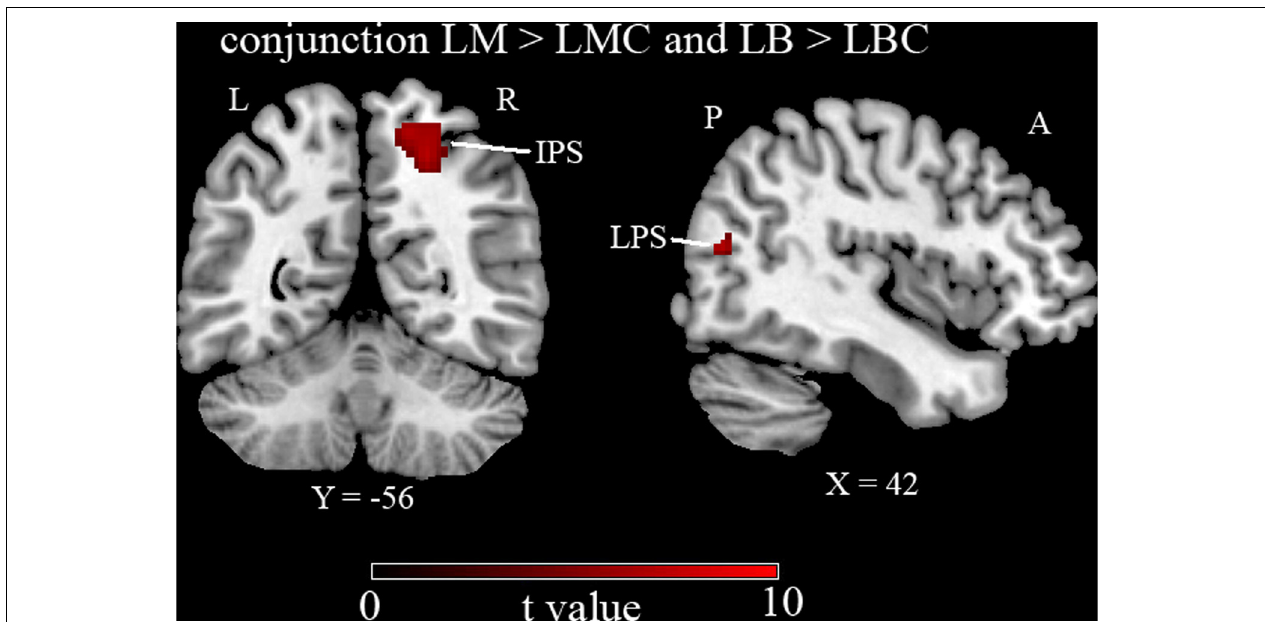
FIGURE 3 | Group results thresholded at p < 0.05 corrected for multiple comparisons. Intra-parietal sulcus (IPS) and lateral peristriate cortex (LPS) activated (please see Table 2 for coordinates) commonly for both Landmark and Line Bisection tasks (LM-LMC inclusively masked with LB-LBC). A, anterior; P, posterior; L, left; R,